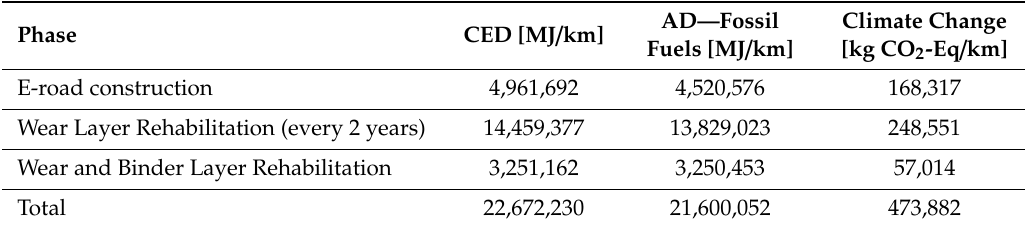
Table 14. The impacts of an e-road construction and maintenance for a lifetime of 20 years.